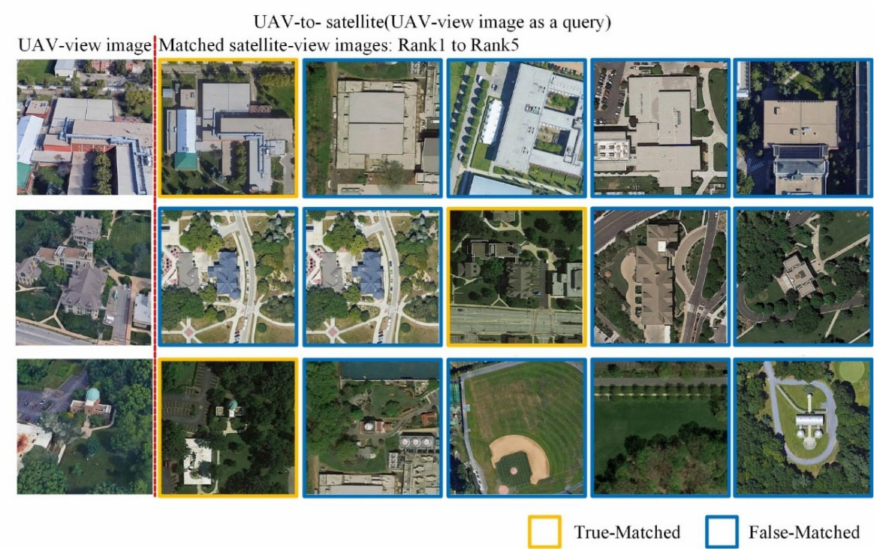
Figure 7. The top five images in the ranking of the matching result for UAV-to-satellite when a single UAV-view image is used as the